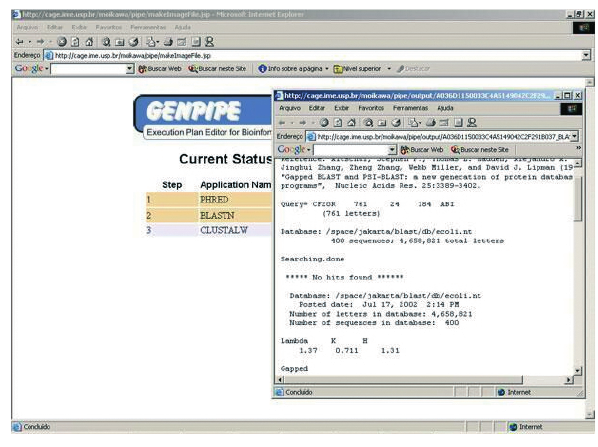
Figure 4 - Running